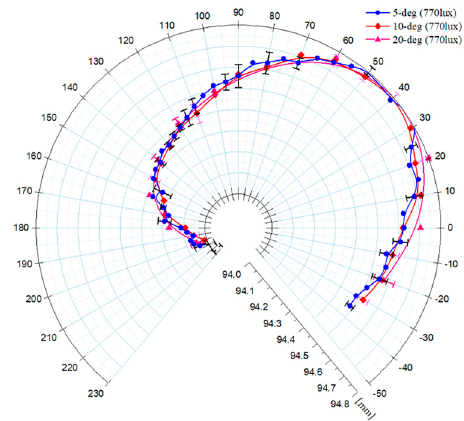
Figure 18. Results of circle fittings with respect to frame {Nc} under the 770-lux light-intensity condition.